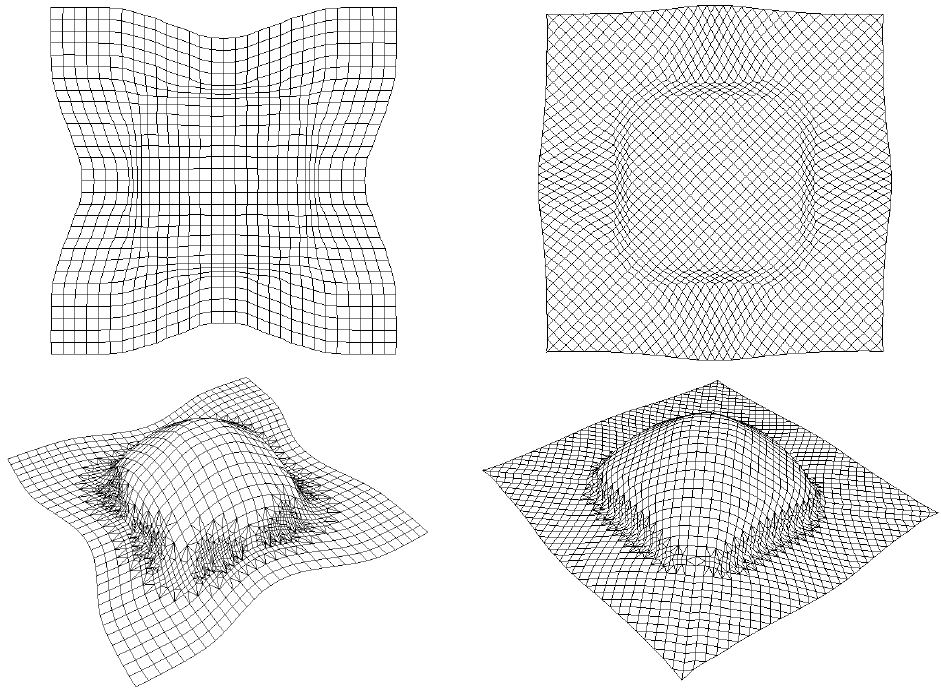
Figure 14. Numerical results with and without remeshing